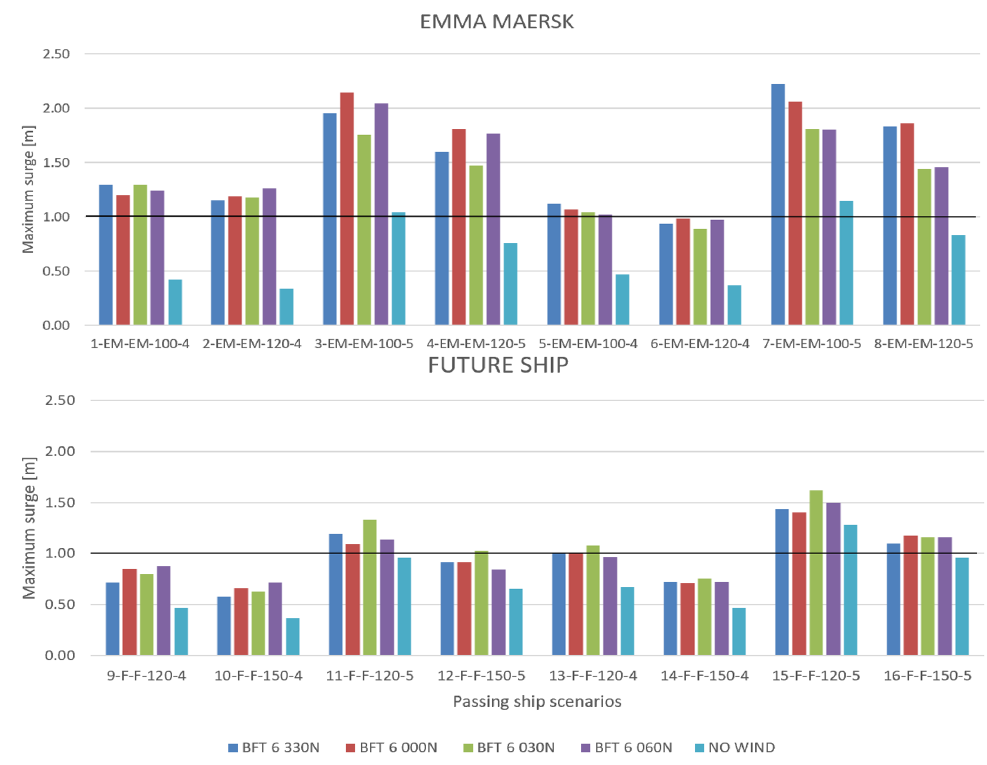
Figure 15. Maximum surge motion results for the Emma Maersk and the future vessel subjected to passing-ship conditions.